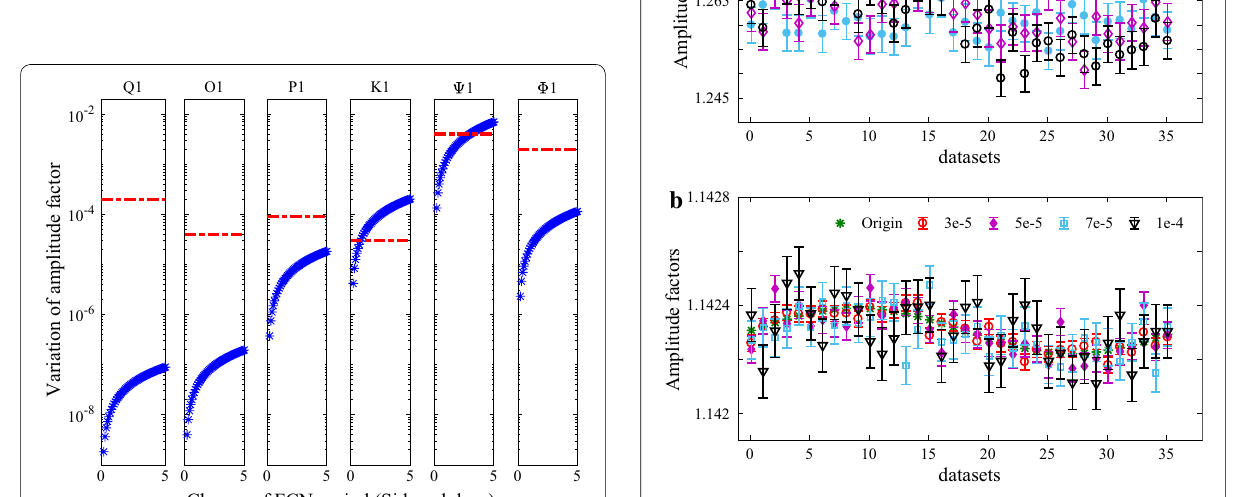
Fig. 3 a Sensitivity of ψ1 to FCN period variation. Three different markers represent the variation in amplitude factor for ψ1 wave caused by different FCN period changes in 36 synthetic time series; b sensitivity of K1 to FCN period variation. The green star is the theoretical FCN period set in 36 synthetic time series. The other four markers represent the variation in amplitude factor for K1 wave under different observation